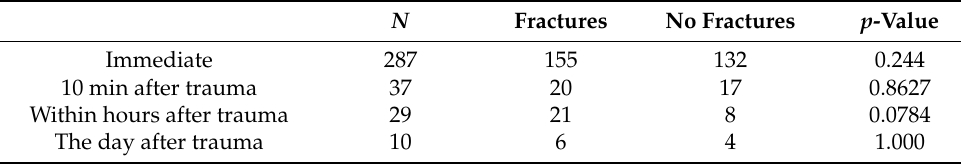
Table 3. Pain onset (Fisher’s exact